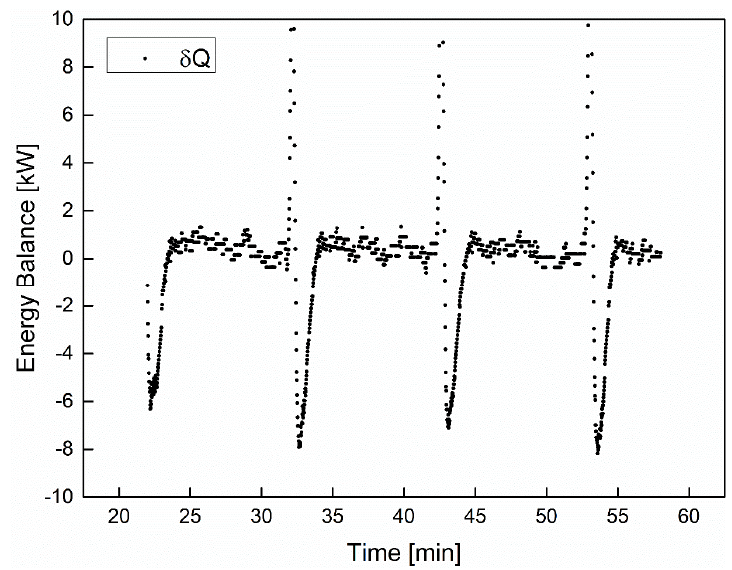
Figure 12. Energy balance variation during the three cycles’ operation.